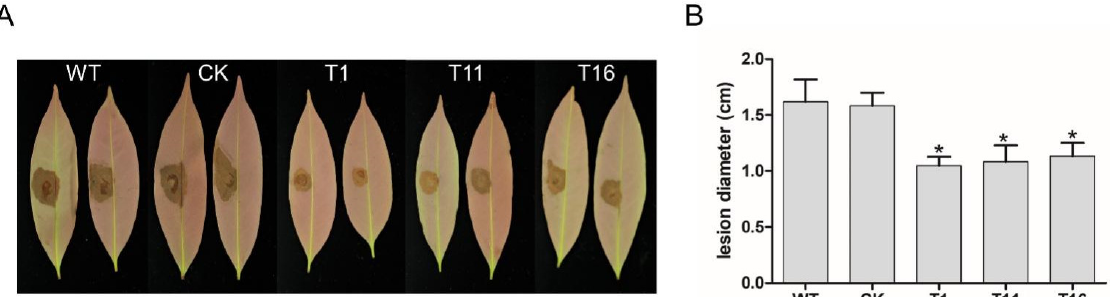
Figure 7. Pathogenicity test of Peronophythora litchii ∆ plczf1 mutants, WT and CK strains. ( A ) My- celial mats were inoculated on tender litchi leaves ( n = 30 for each strain) for 48 h at 25 °C in the dark. Images are two representatives for each instance. ( B ) Quantification of pathogenicity by dis- ease severity values. Asterisks denote a significant difference between ∆ plczf1 mutants and two controls (Dunnett’s test, * p < 0.05). This experiment was repeated three times independently, and each repeat with three biological replications.